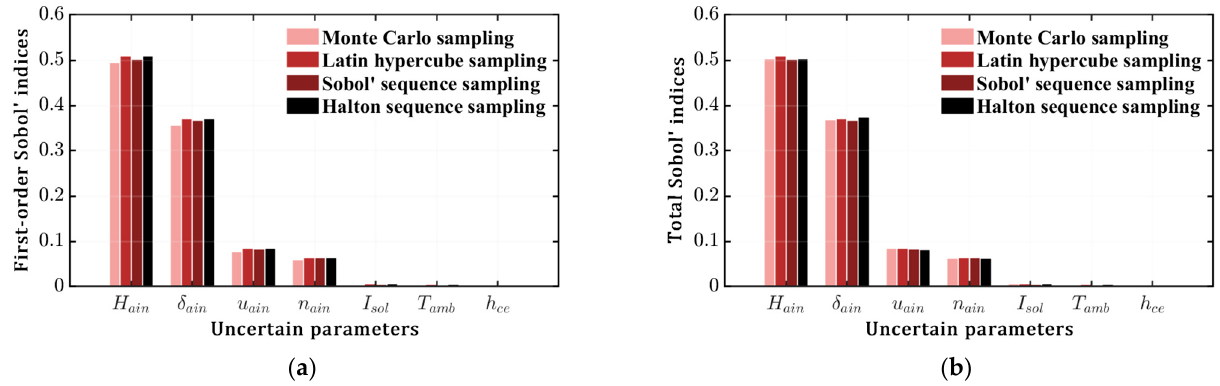
Figure 8. The difference between first-order and total Sobol’ indices obtained based on four sampling strategies: ( a ) first-order Sobol’ indices; ( b ) total Sobol’ indices.